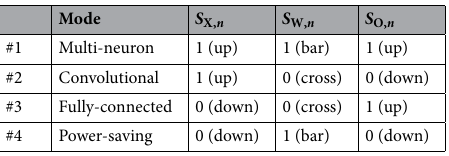
Table 1. PPNN modes of operation and the corresponding switch states.